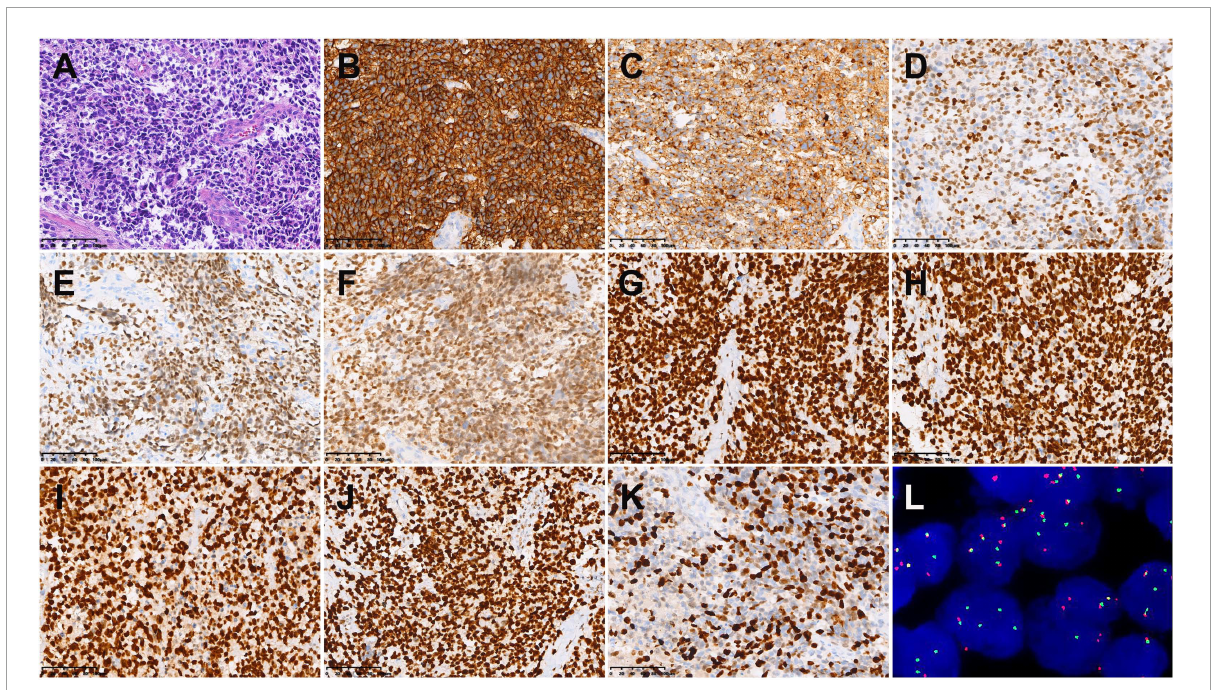
FIGURE4 Histopathological results in case 1. (A) Hematoxylin-eosin (HE) staining ( × 200). Immunohistochemistry showed that the tumor cells were positive for CD56 (B) , Syn (C) , SOX-10 (D) , MyoD1 (E) , Myogenin (F) , MSH2 (G) , MSH6 (H) , MLH1 (I) , PMS2 (J) , and MSH6 (K) [Envision (B–K) × 200]. (L) Fluorescence in situ hybridization revealed FKHR gene rupture ( × 1,000).